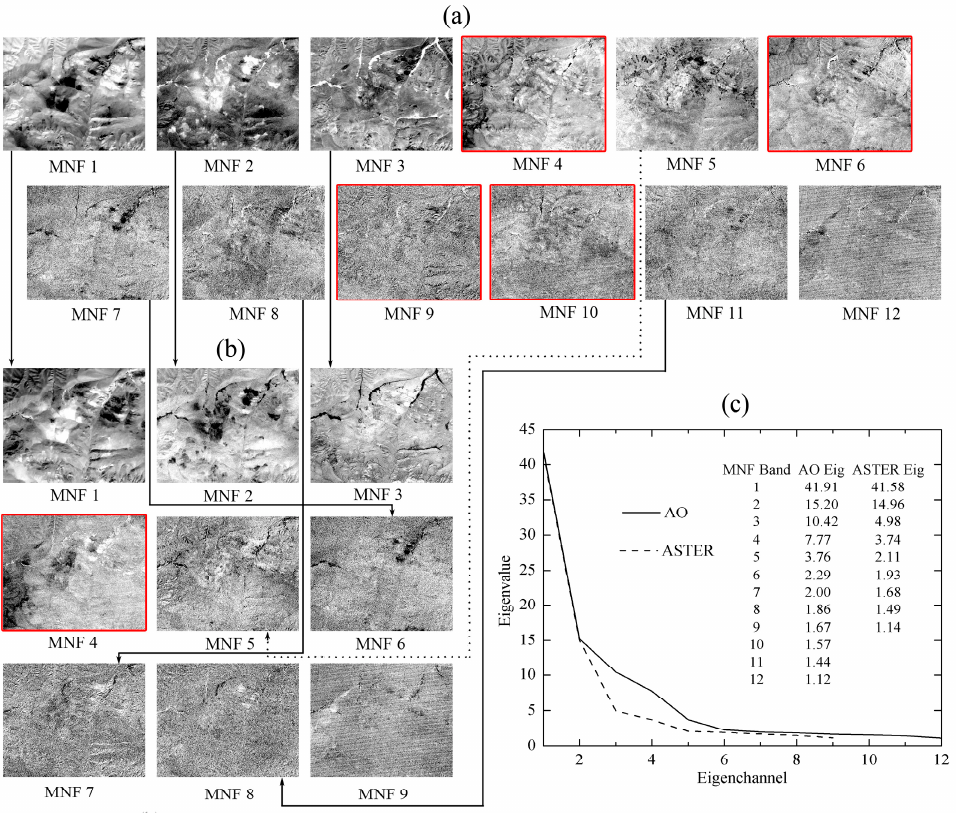
Figure 6. The MNF images and eigenvalues (Eig) of AO and ASTER data. ( a ) The MNF images of AO data; ( b ) The MNF images of ASTER data; ( c ) The eigenvalues of AO MNF and ASTER MNF images. Overall, it indicates that the combination of ASTER and L8 OLI data (AO) has more mineral information content than either